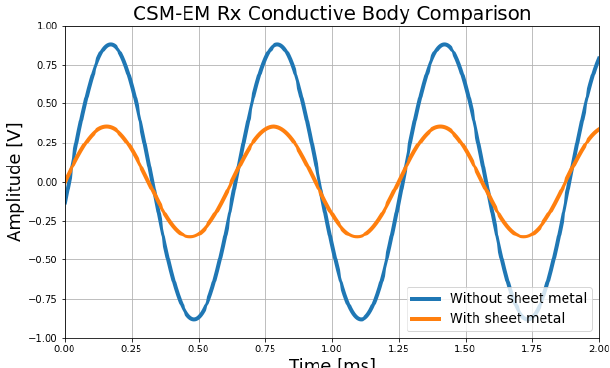
Figure 7. CSM-EM R x signal measured on an oscilloscope using an R x gain of G = 100 at a 10m T x - R x offset with (orange curve) and without (blue curve) introducing a piece of sheet metal near the R x antenna. The signal with the sheet metal present is less than half the amplitude of that without metal present. The CSM-EM T x generated the signal for both